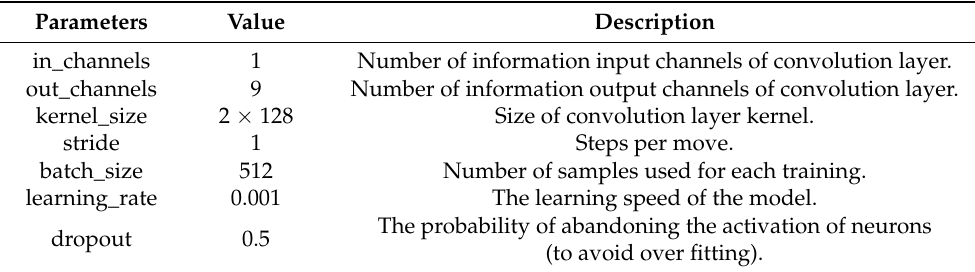
Table 2. TextCNN parameters from torch.nn